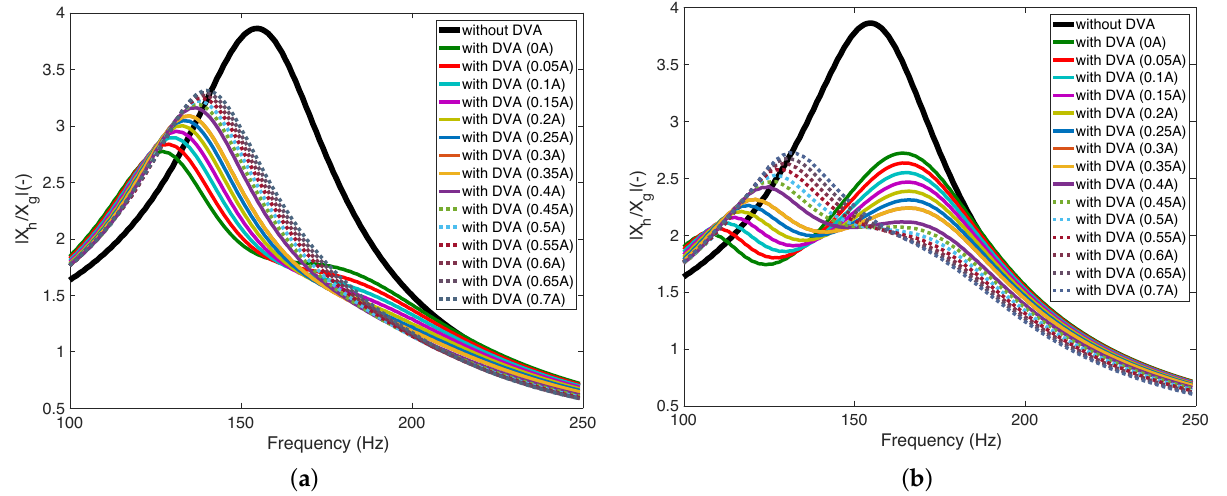
Figure A1. Simulated vibration isolation performances of the MRE-DVAs using the equivalent mechanical model: ( a ) 1 mm thickness and ( b ) 2 mm